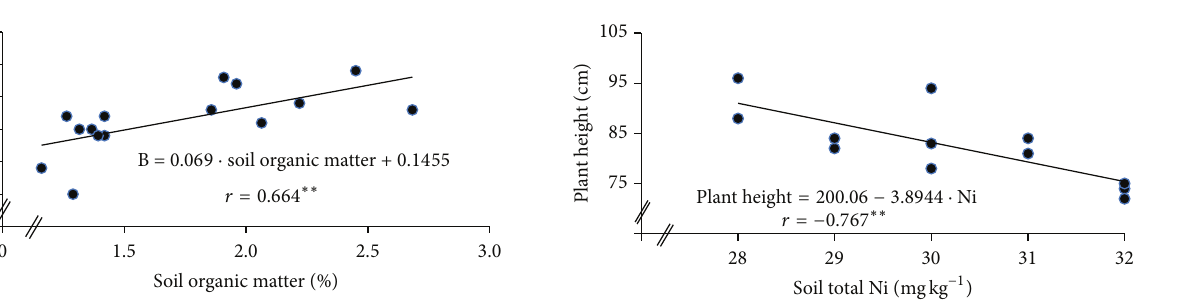
Figure 3: Regression curve between Ni content of soil and plant height in the 2006 experiment ( ∗∗ 𝑝 < 0.01 ).